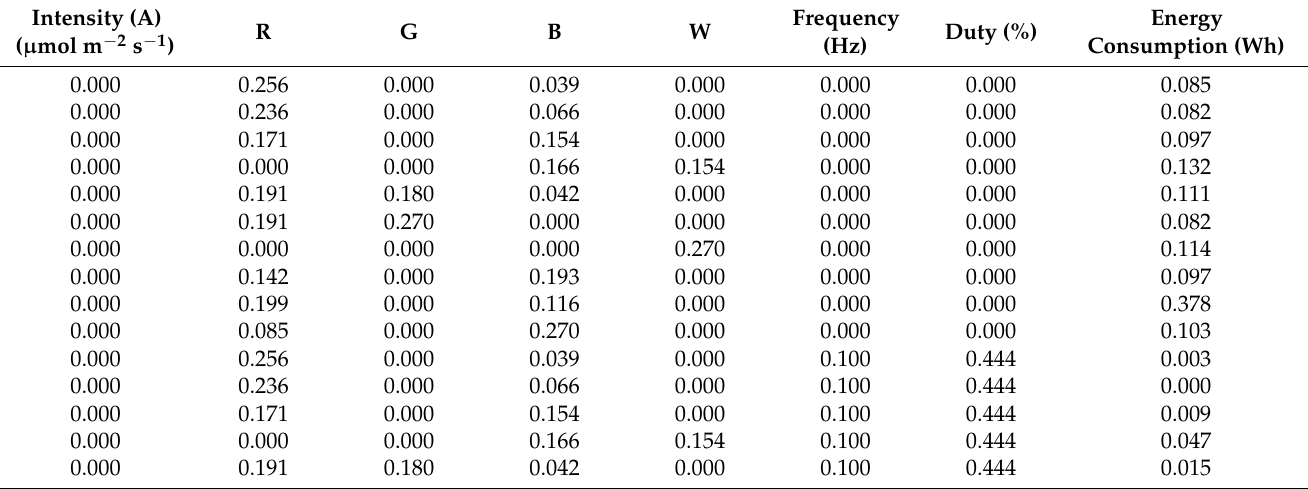
Table 2. First 15 scaled dataset measurements.